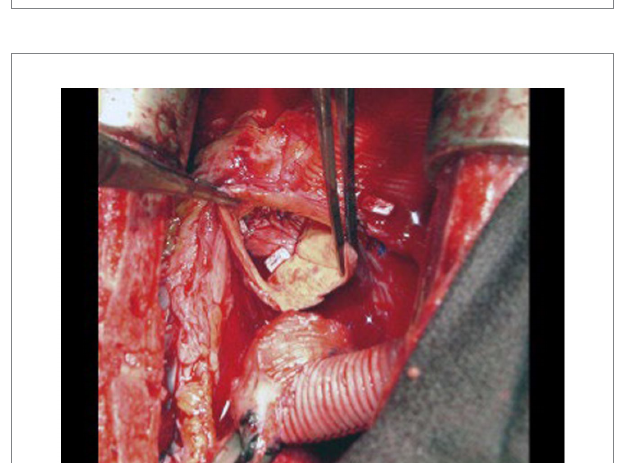
FIGURE 5 Modified park’s stitch.